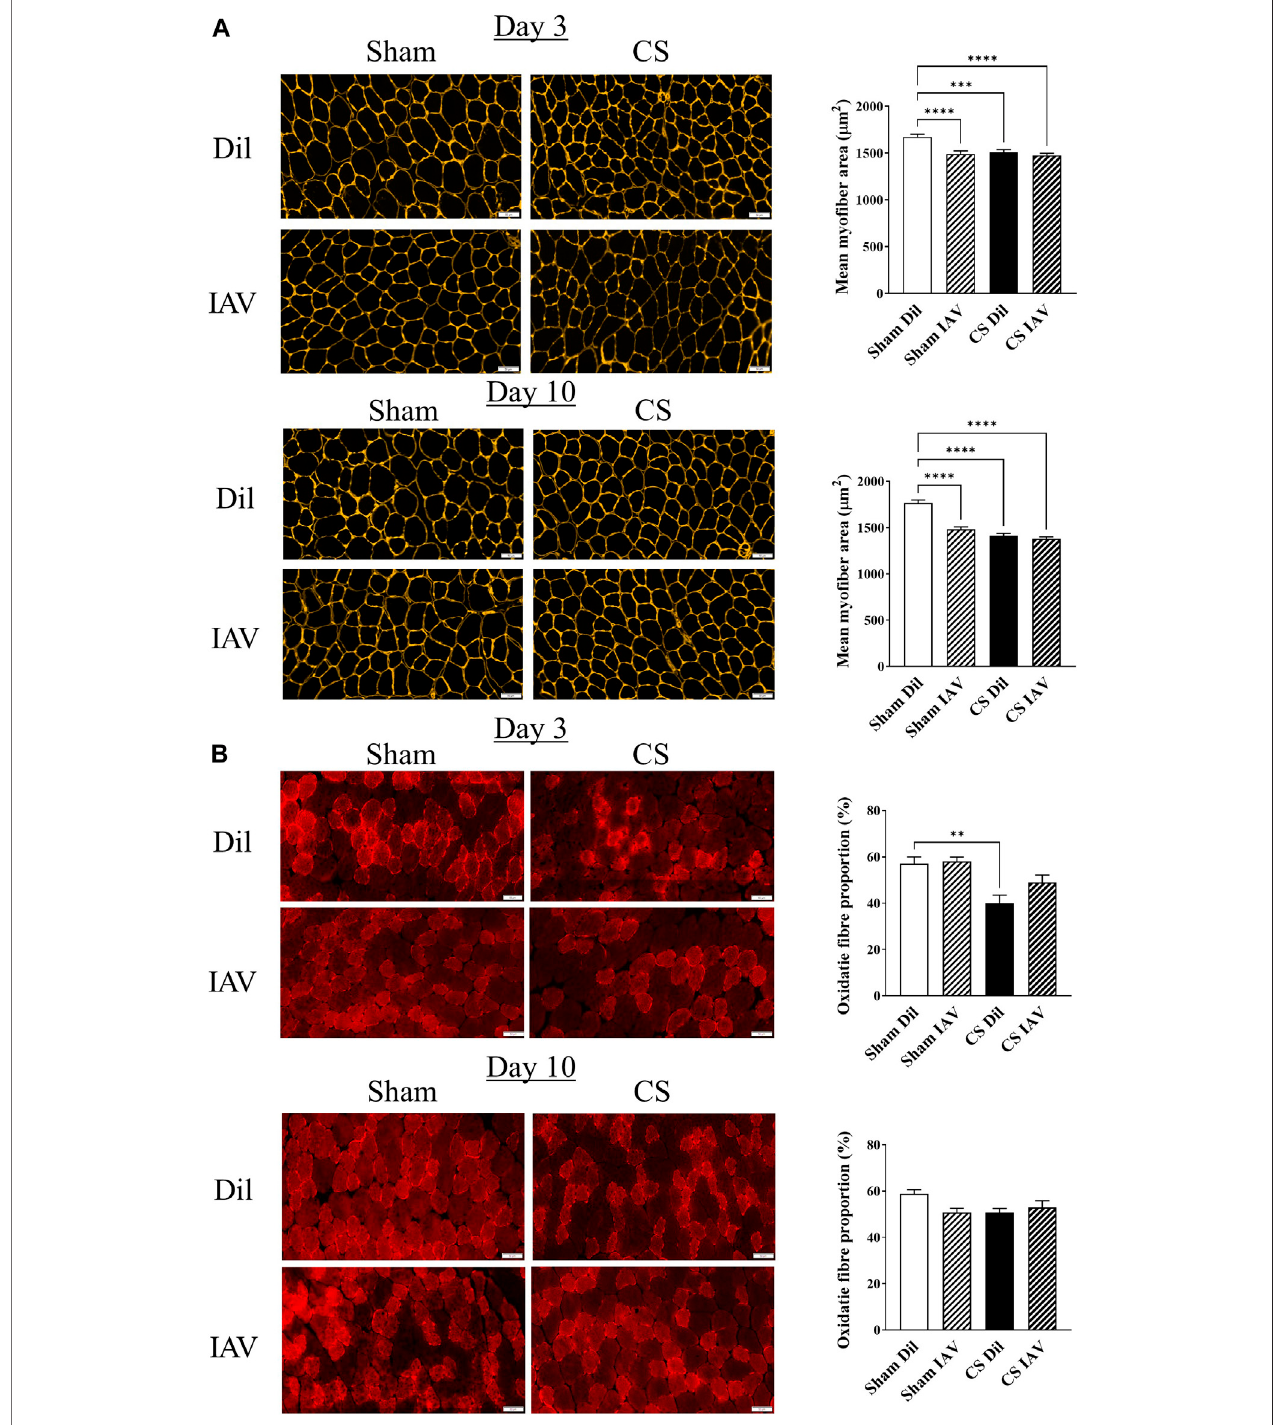
FIGURE 3 | Effect of CS exposure and in fl uenza A virus (IAV) infection on morphology of tibialis anterior (TA) muscle. Immuno fl uorescent examination and quantitative data of (A) myo fi ber cross-sectional area with laminin staining and (B) fi ber distribution with slow myosin heavy chain staining, in cross-sectioned TA of CS- exposedand/orIAVinfectedmice3-and10-dayspostinfection.Scalesbars:50 µm.Atleast600 fi berswerecountedperanimal.Datashownasmean+SEM( n =5per group). ** p < 0.01, *** p < 0.001, **** p < 0.0001.